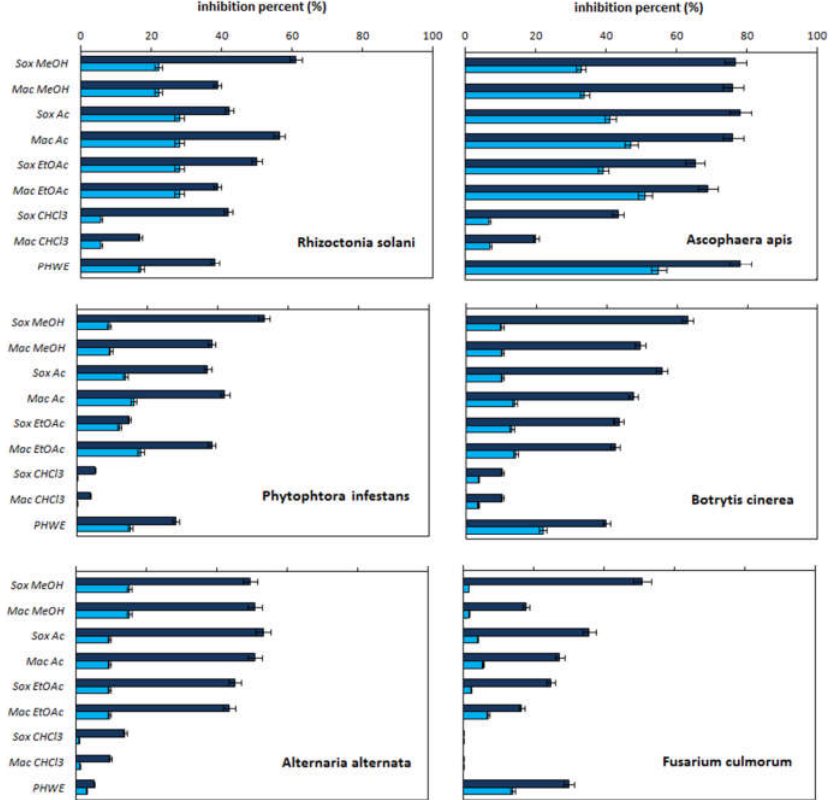
Figure 1. Comparison of the inhibition activity of mycelium growth by the white onion scale extracts (navy blue bars) obtained by pressurized hot water extraction (PHWE), extraction in the Soxhlet apparatus (Sox), and maceration (Mac) using different extractants [methanol (MeOH), acetone (Ac), ethyl acetate (EtOAc) or chloroform (CHCl3)] and by the quercetin solutions (blue bars) with the same quercetin concentrations as those in the onion scale